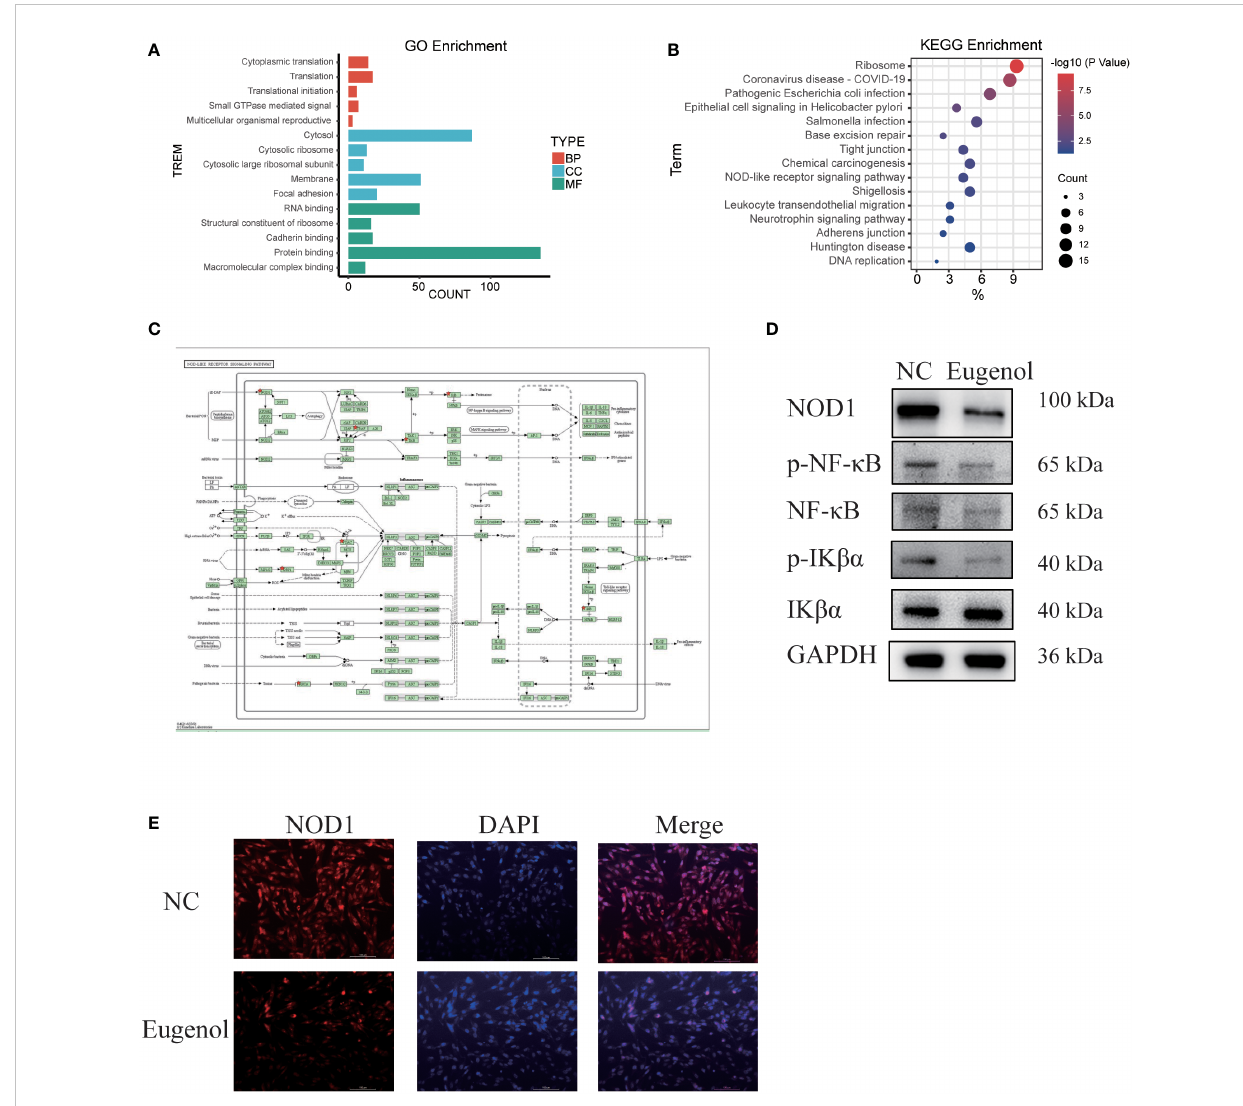
FIGURE 4 Main functional classi fi cation with the most signi fi cant enrichment of the differentially expressed proteins. (A) GO enrichment analysis of differentially abundant proteins in biological process, cellular component, molecular function. (B, C) KEGG pathway enrichment analysis of differentially abundant proteins. (D) Western blot experiment veri fi ed the effect of eugenol on signal pathway. (E) Detection of NOD1 expression after eugenol treatment by immuno fl uorescence